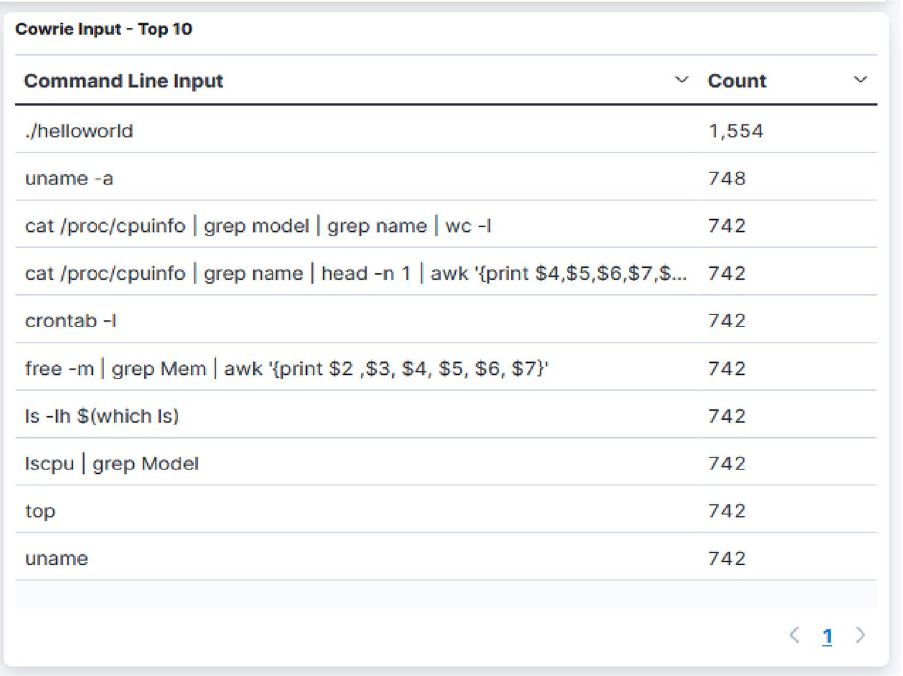
Figure 5. Sample commands executed by the adversaries upon accessing the system.